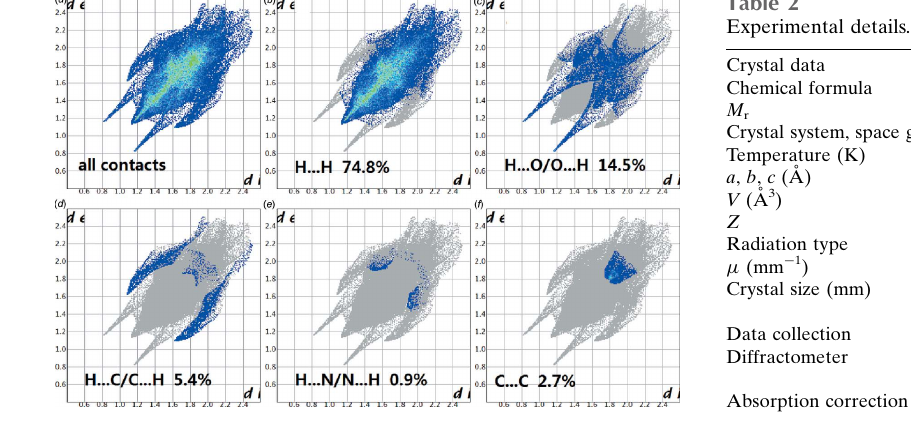
Figure 4 The two-dimensional fingerprint plots of title compound: ( a ) all contacts; ( b ) H (cid:2)(cid:2)(cid:2) H, ( c ) H (cid:2)(cid:2)(cid:2) O/O (cid:2)(cid:2)(cid:2) H, ( d ) H (cid:2)(cid:2)(cid:2) C/C (cid:2)(cid:2)(cid:2) H, ( e ) H (cid:2)(cid:2)(cid:2) N/N (cid:2)(cid:2)(cid:2) H and ( f ) C (cid:2)(cid:2)(cid:2)